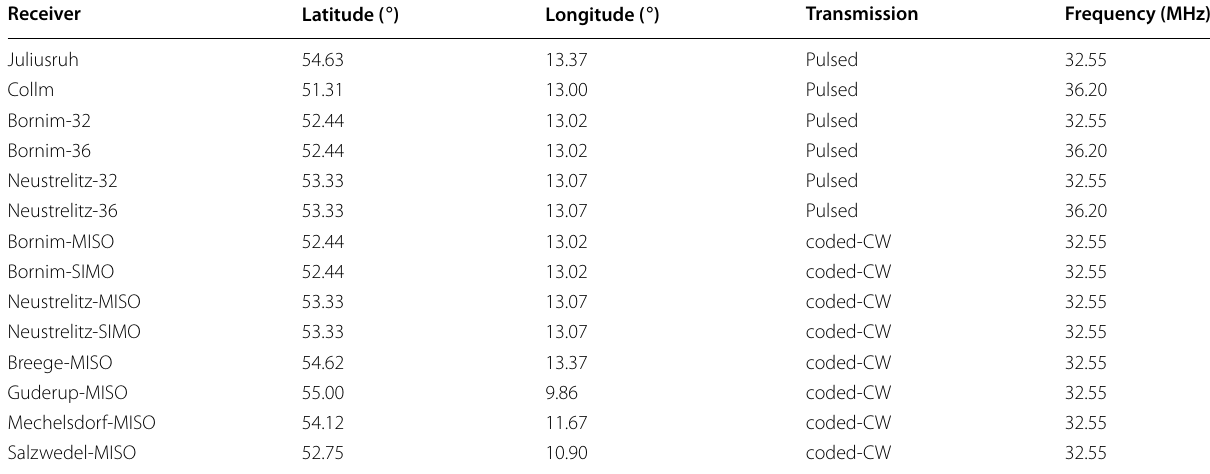
Table 1 Receiving sites for the SIMONe 2018 campaign. The name contains information about the frequency or the MIMO type to help the